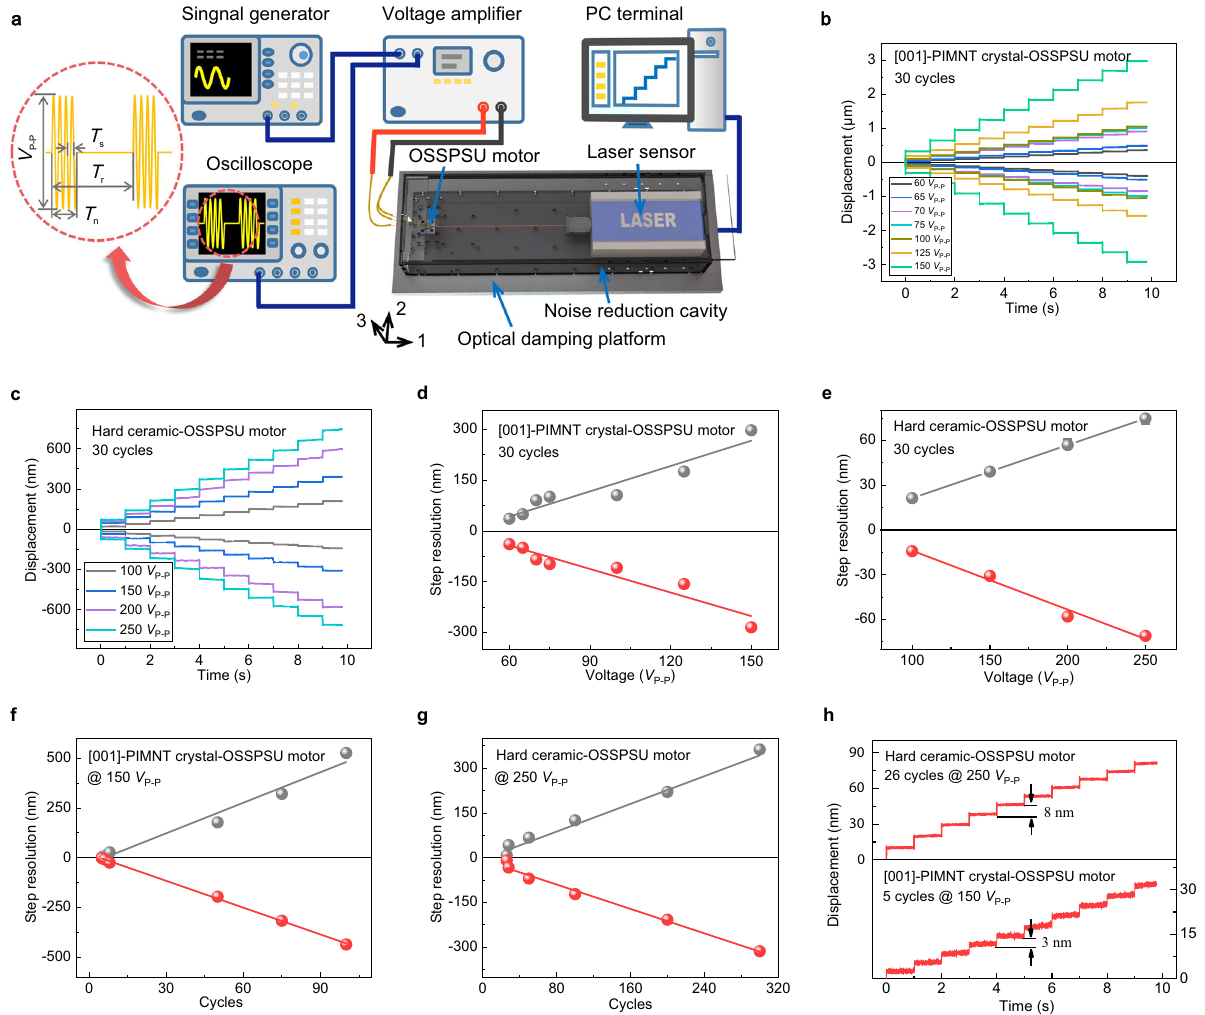
Fig.6|ExperimentalresultsofnanostepmotioncharacteristicsfortheOSSPSU motors under the same period of pulse signals. a The graphical setup for mea- suring the resolution of the ultrasonic OSSPSU motors and the voltage driving signal for step motion. Where T s refers to the period of a single sinusoidal pulse signal, T n represents the period of n pulse signals, and T r (set to 1second) represents the period of the step test. b The bidirectional motion steps of [001]- PIMNT crystal-OSSPSU motor under different voltages (at 30 cycle). c The bidir- ectional motion steps of hard ceramic-OSSPSU motor under different voltages